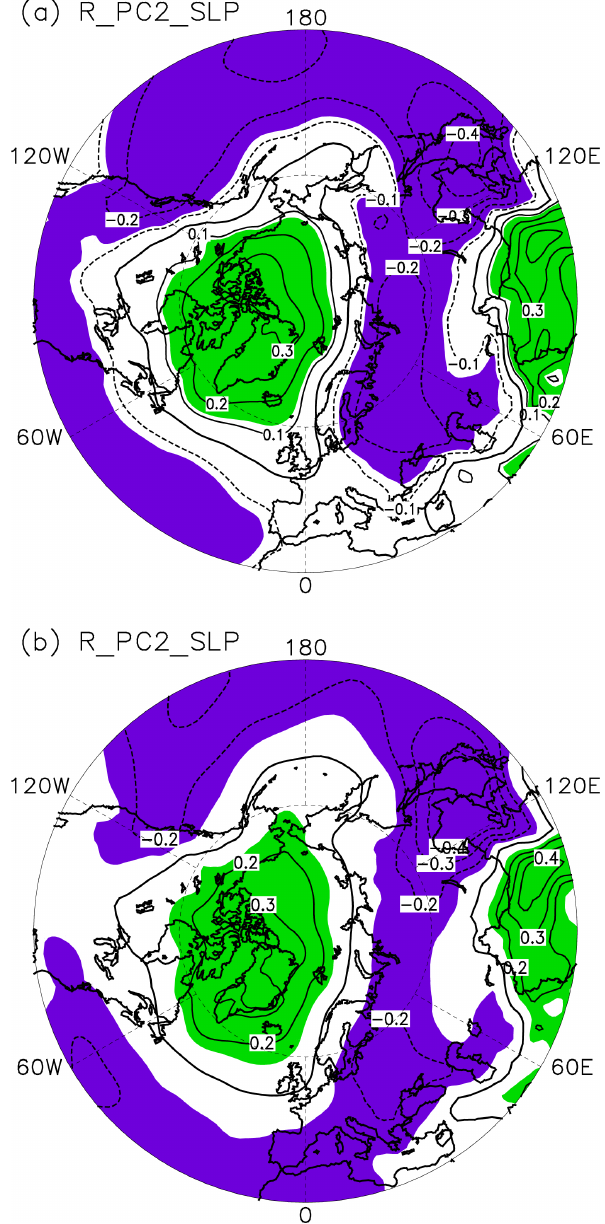
Figure 6. Spatial distribution of the correlation coefficients be- tween the monthly sea level pressure and PC2 of the (a) surface and (b) column PM 2 . 5 concentrations. Color shading indicates sig- nificance at the 0.05